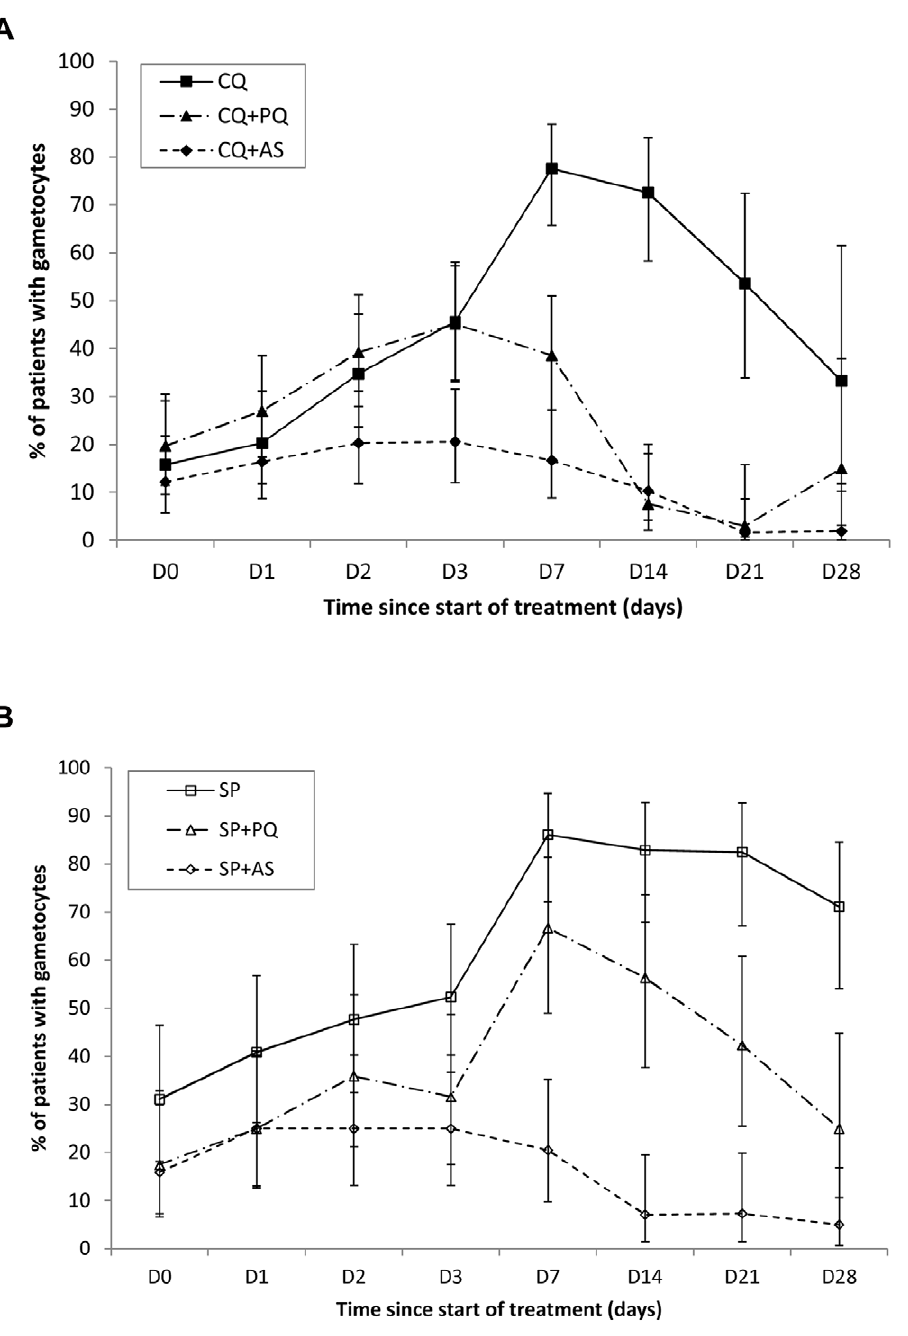
Figure 3. Percentage of patients ( + CI) carrying gametocytes on specified days after treatment in CQ (A) and SP (B) treatment arms.